Question: Give a one-sentence summary of this figure.
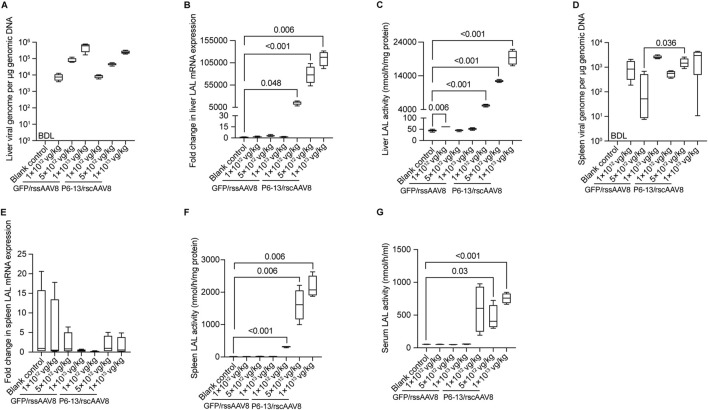
Answer: Expression and biodistribution of virally transduced lysosomal acid lipase (LAL) in wild-type mice. Mice were treated as shown in Figure 1B . (A–G) Wild-type mice received a single intravenous injection of P6-13/rscAAV8 or GFP/rssAAV8 at 0.1, 0.5 or 1 × 10 13 viral genomes per kg (vg/kg) (depicted on plots from left to right) and euthanized 11 weeks later. A group of wild-type mice receiving PBS injection was included as a blank control. (A-C) Analyses of liver tissue (n = 4). (D–F) Analyses of spleen tissue (n = 4). (G) Analysis of serum (n = 4). Statistical comparisons were performed against the PBS control group, except for panels displaying viral genomes (A,D) , where GFP/rssAAV8 was compared to P6-13/rscAAV8 since the values in the control group were below the detection limit (BDL). All p values are Bonferroni-adjusted for multiple comparisons.